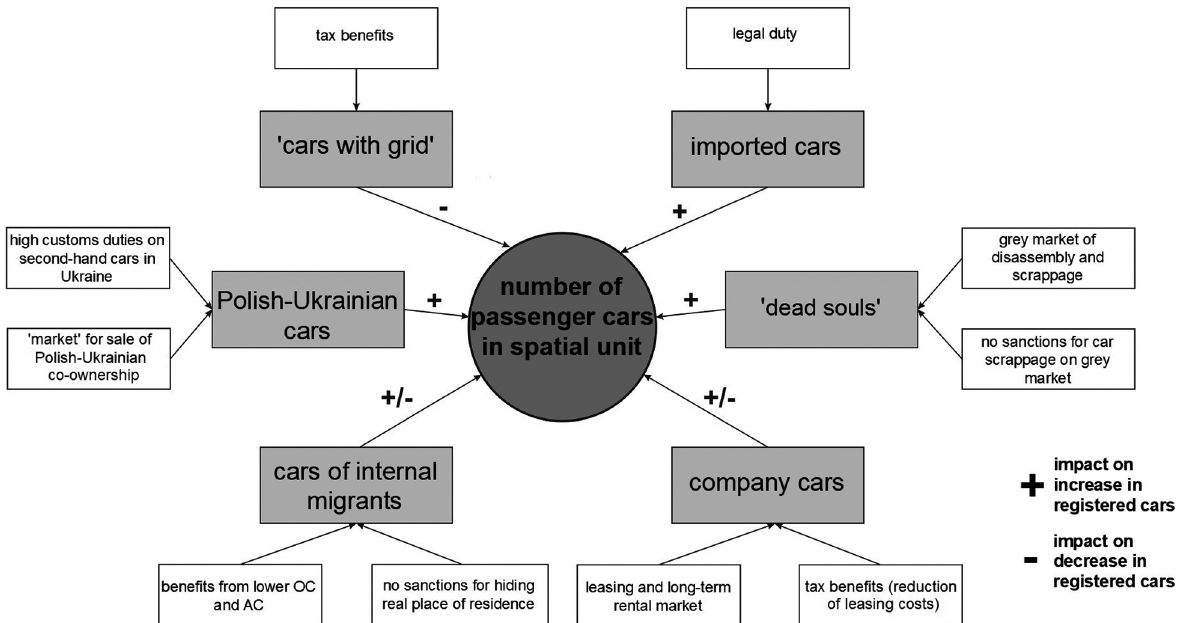
Fig. 1. Impact of the shortcomings of motorisation statistics and their causes on the number of passenger cars registered in a given territorial